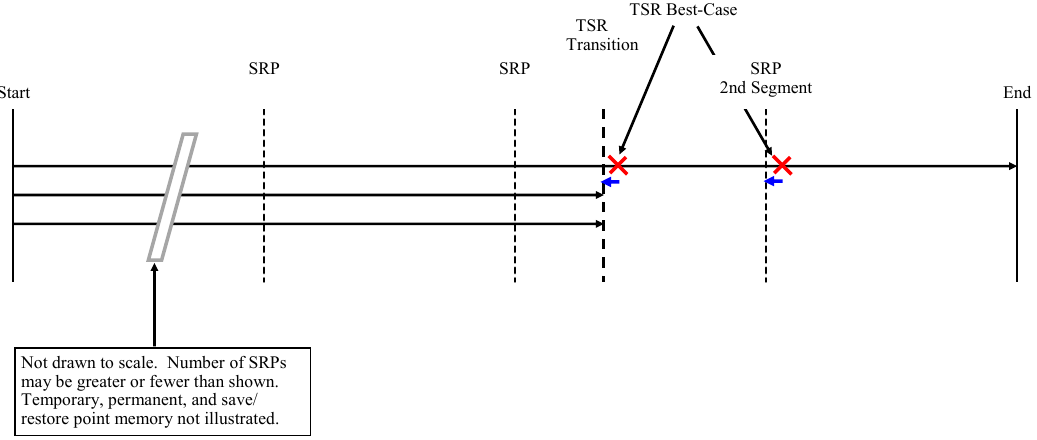
Figure A14. AHR MIPS TSR Best-Case Early Error Timing Diagram 2.